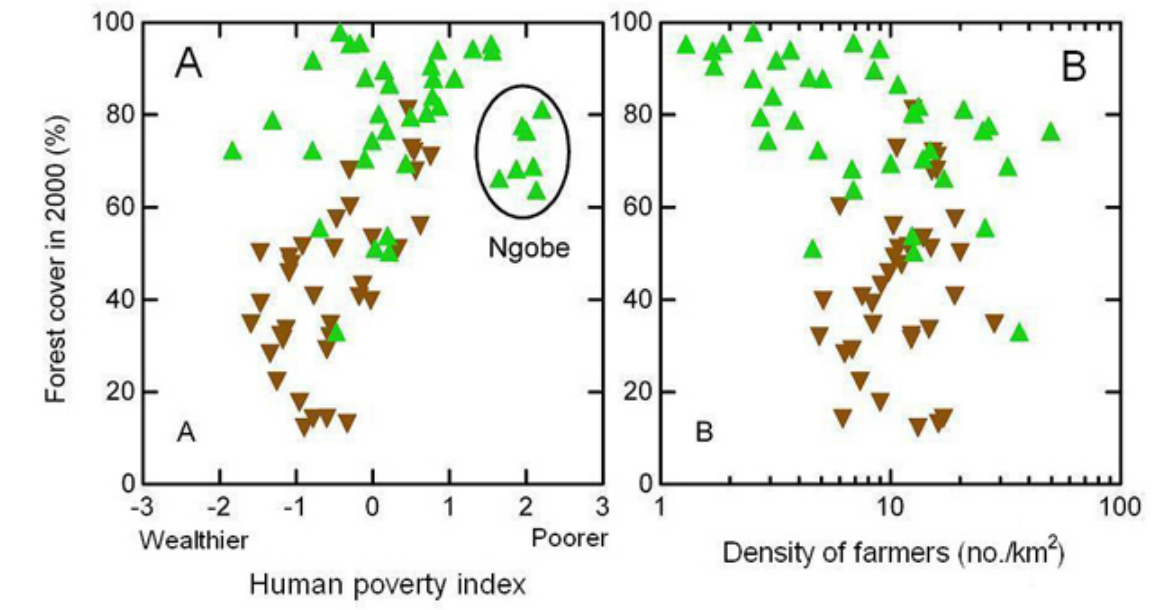
Fig. 8. The relationship between total forest cover in 2000 and (A) an index of human poverty and (B) the population density of agricultural workers for 74 districts in Panama. The human poverty index (HPI) is ordered from wealthiest to poorest, with the seven districts in the Ngobe indigenous area being among the poorest. The HPI integrates literacy, poverty (monthly family income < US$100), age structure (proportion < 15 yr old), housing (proportion improvised), and occupation (proportion in agriculture) as first principal component factor scores. Brown downward-pointing triangles indicate districts that were largely deforested before 1947; green upward-pointing triangles indicate districts that were largely forested in